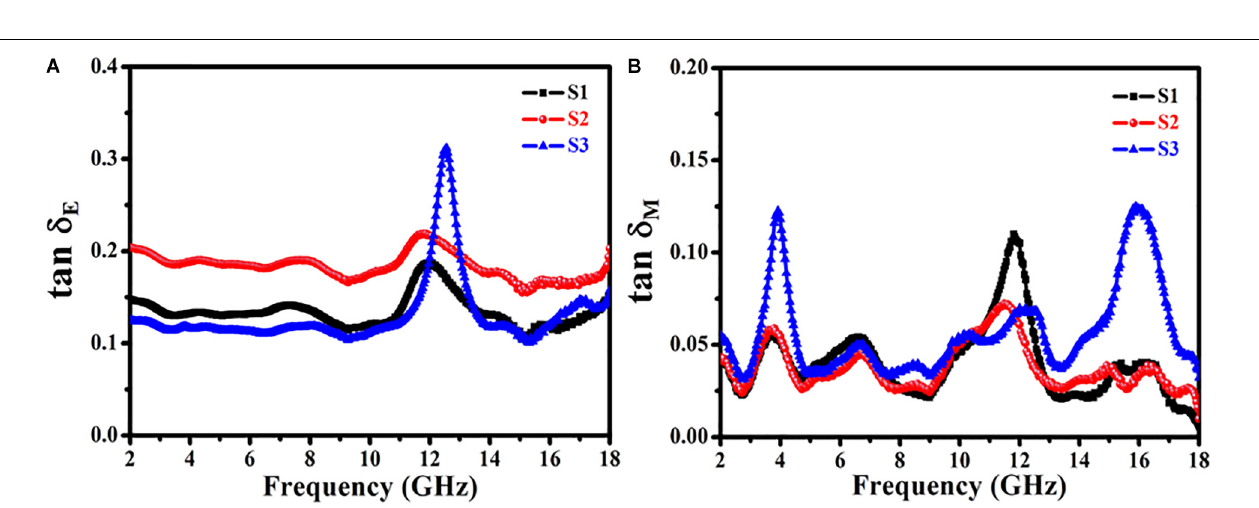
FIGURE 11 | Frequency dependence (A) dielectric loss tangent, and (B) magnetic loss tangent of the as-prepared samples.